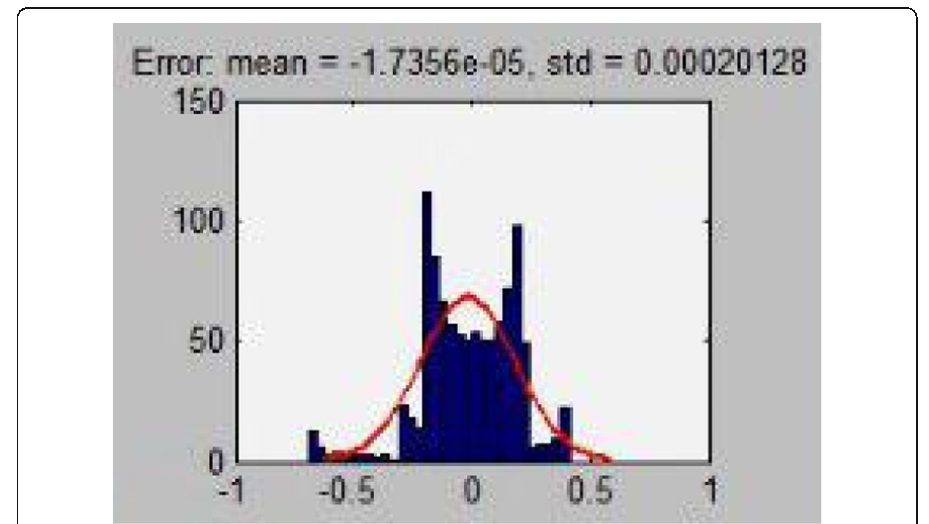
Fig. 14 K-means MSE. There are some clustering methods like K-Means, FCM, and subtractive. To find which one is the best for our research, we have clustered the customers using K-Means, FCM, and subtractive clustering methods and compared the methods ’ MSEs. The MSEs (Mean-Square Error) of the k-means is shown in Fig. 14. The error mean is= − 1.7356e-0.5 and std. =0.00020128. The Mean squared error (MSE) measures the average of the squares of the